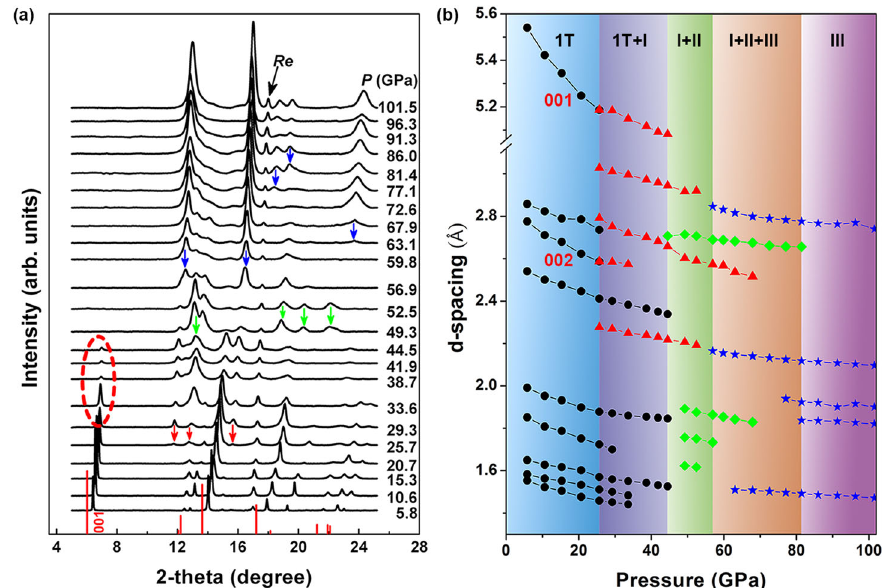
Fig. 2 Structure evolution under pressure. a Synchrotron Angle Dispersive X-ray Diffraction (ADXRD) patterns for 1T-TaS 2 up to 101.5 GPa. The red sticks represent the peaks of the original 1 T structure. The red/green/blue arrows mark the appearance of new Bragg peaks. The black arrow marks the (101) peak of Reused as a gasket. b Evolution of d-spacing with increasing